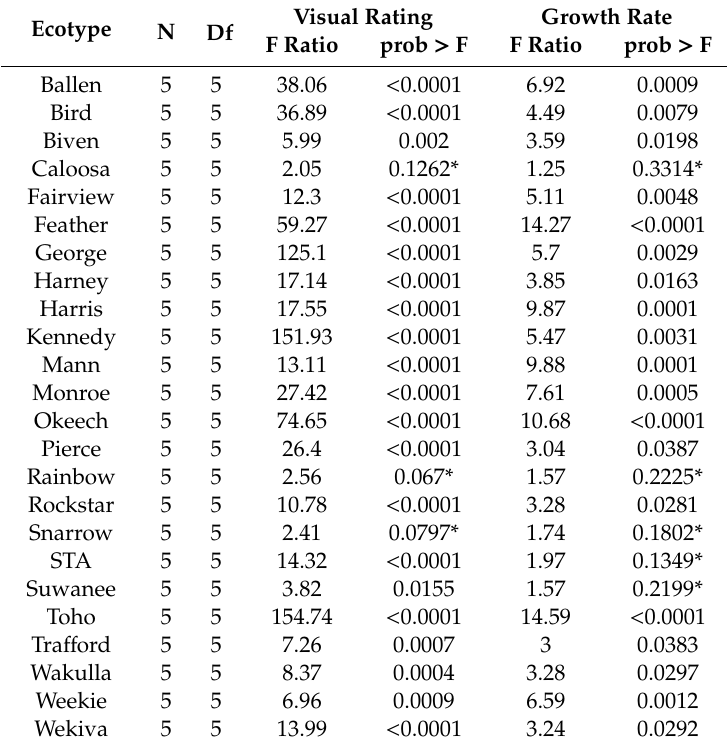
Table A3. E ff ect of salinity on visual rating and growth rate of Vallisneria americana